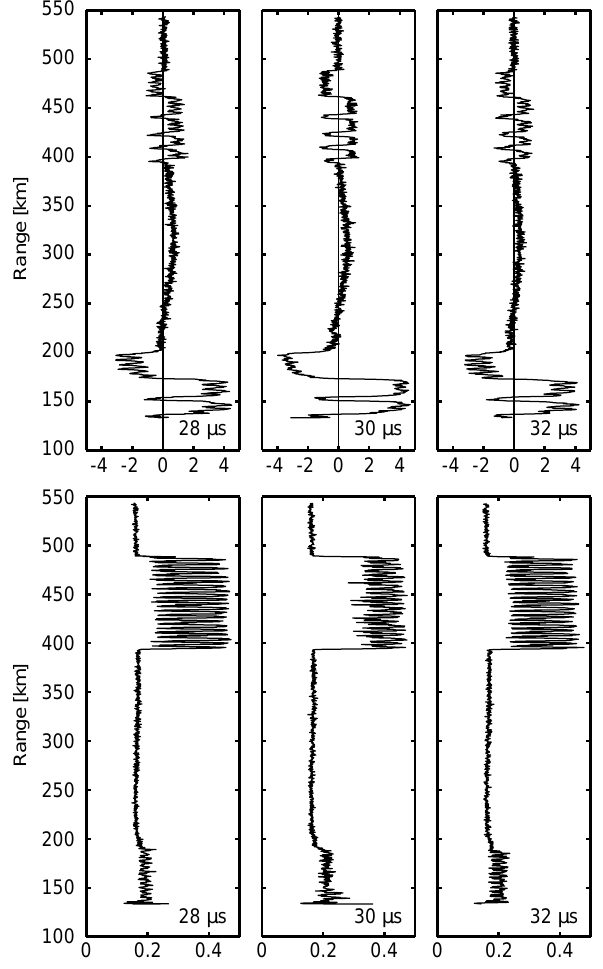
Fig. 4. Top: Three measured average lag profiles for a same 5- min period of observation (real part). The 30- µ s lag is a full lag and the other two are neighbouring fractional lags. Bottom: The corresponding profiles of experimental standard deviation.